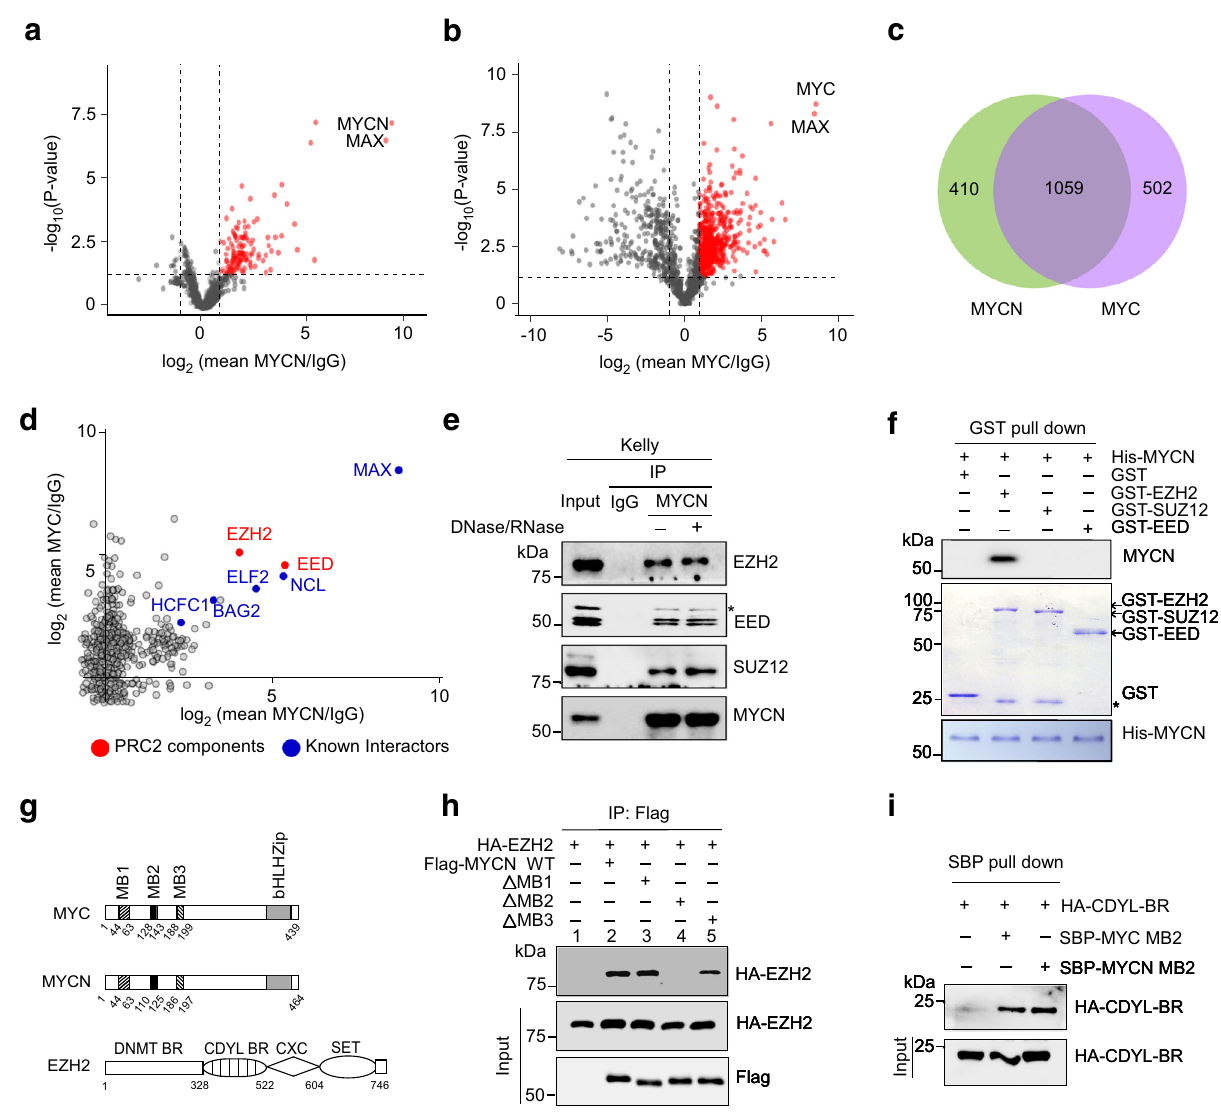
Fig. 1 Identi fi cation of EZH2 as a MYCN/MYC common binding partner. a , b Volcano plots showing interacting proteins of MYCN ( a ) and MYC ( b ). Associated proteins were immunoprecipitated from neuroblastoma Kelly cells ( a ) and small cell lung carcinoma NCI-H2171 cells ( b ) using speci fi c MYCN and MYC antibodies, respectively. Proteins signi fi cantly enriched from three independent experiments with a fold-change >2 and p value < 0.05 against the IgG group are displayed as red dots. c Venn diagram of MYCN- and MYC-interacting partners. d Mass spectrometry results of MYCN and MYC common binding partners. The axes show the fold-change of α -MYCN/MYC-associated proteins relative to α -IgG control. e Co-immunoprecipitation (Co-IP) to detect interaction between endogenous MYCN and PRC2 components. Lysates of Kelly cells were treated with a DNase/RNase (10 μ g/mL) combination and subjected to co-IP for detecting protein interaction. The asterisk denotes a nonspeci fi c band. f GST pull-down to identify the direct MYCN-binding partner. Recombinant His-tagged MYCN was respectively incubated with GST-tagged EZH2, SUZ12, and EED in vitro before pulldown assay with GST beads, and MYCN interaction was analyzed by immunoblot with anti-His antibody. The asterisk denotes a nonspeci fi c band. g Schematic representation of MYC, MYCN, and EZH2. MB1, 2, and 3: MYC box1, 2, and 3, respectively; bHLHZip: helix – loop – helix domain; DNMT BR: DNA methyltransferase-binding region; CDYL BR: chromodomain Y-like protein-binding region; CXC: cysteine-rich domain, SET: Su(var)3 – 9, enhancer of zeste, trithorax domain. h Characterization of the MB motif required for MYCN and EZH2 interaction. 293T cells were transfected with plasmids expressing epitope-tagged EZH2, MYCN, or its MYC box deletion ( Δ MB) mutants as shown. Anti-Flag-associated precipitates were used for detection of EZH2 binding. i Analysis of EZH2 CDYL-BR and MYCN/MYC MB2 interaction. 293T cells were transfected with plasmids expressing EZH2-CDYL-BR, and Streptavidin-binding peptide (SBP)-tagged MYC or MYCN for 48 h as shown. SBP pull-down was performed to analyze the protein interaction as indicated. The experiments were independently repeated three times with similar results ( e , f , h – i ). Source data are provided as a Source data fi